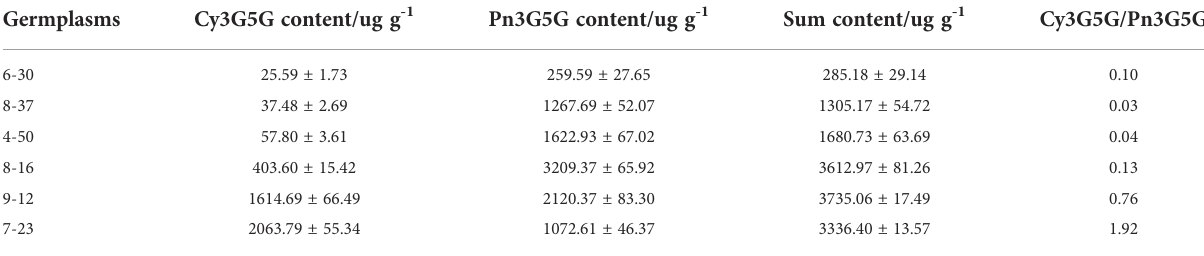
TABLE 1 Contents of Cy3G5G and Pn3G5G in six R. rugosa germplasms based on HPLC